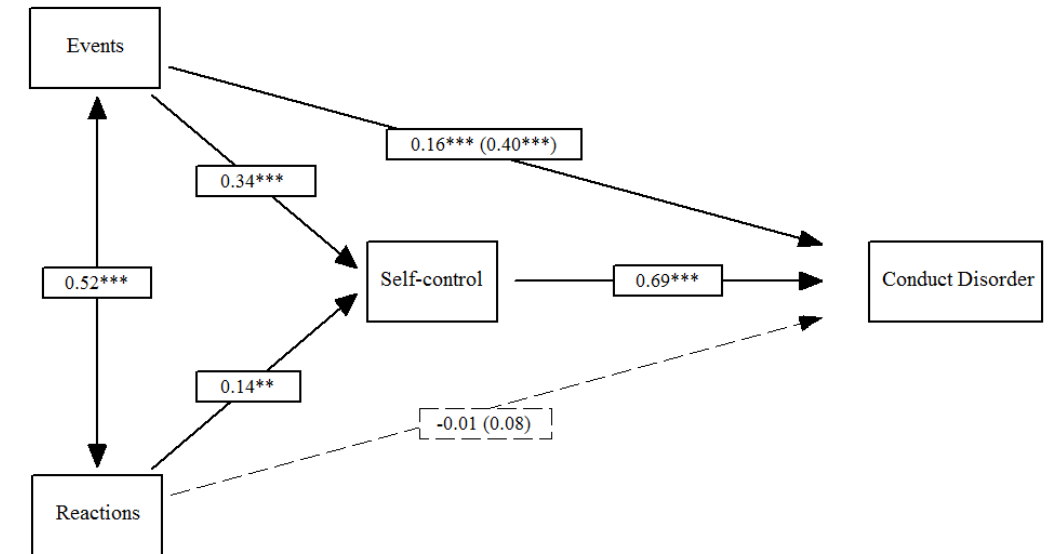
Figure 2. Effects of traumatic events and reactions on conduct disorder mediated by low self-control. Note: Total effects are included in parentheses; ** p ≤ 0.01, *** p ≤ 0.001.